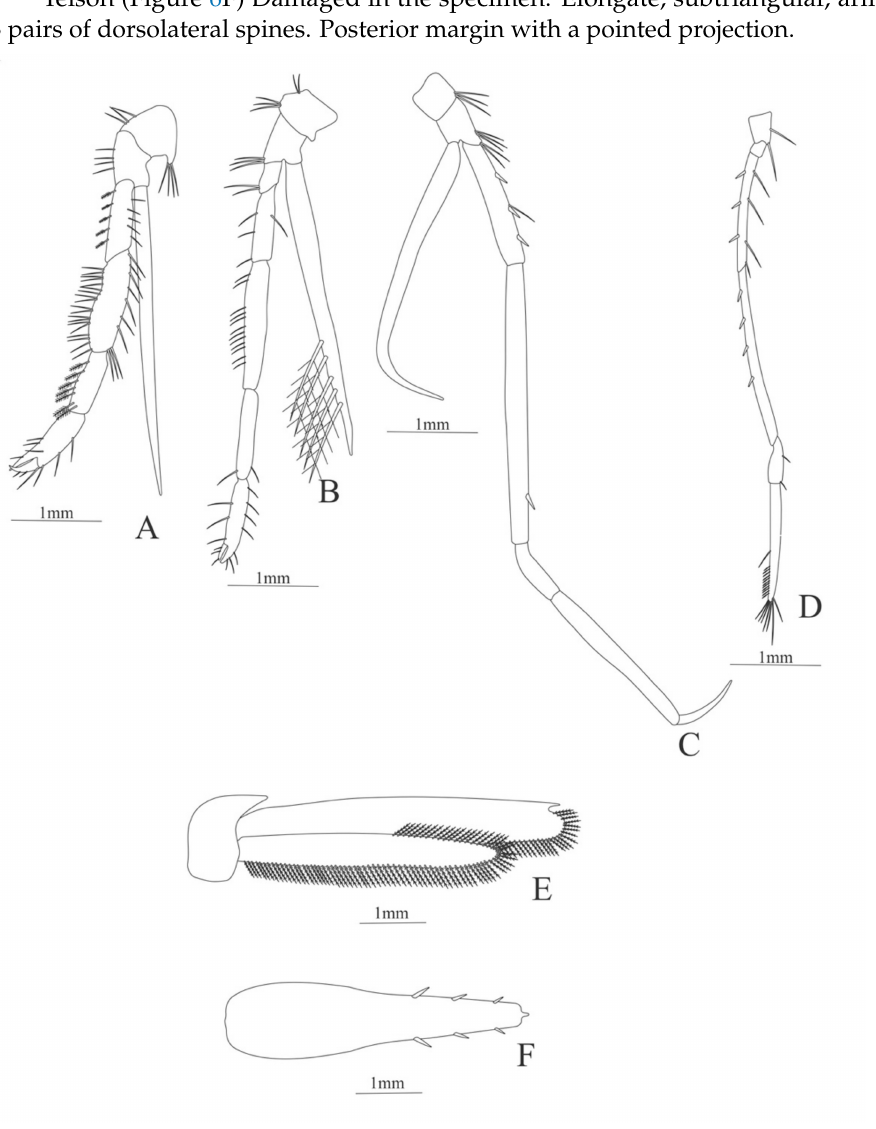
Figure 6. Meningodora vesca : ( A ) first Pereopod; ( B ) second Pereopod; ( C ) third Pereopod; ( D ) fifth Pereopod; ( E ) uropods; ( F )